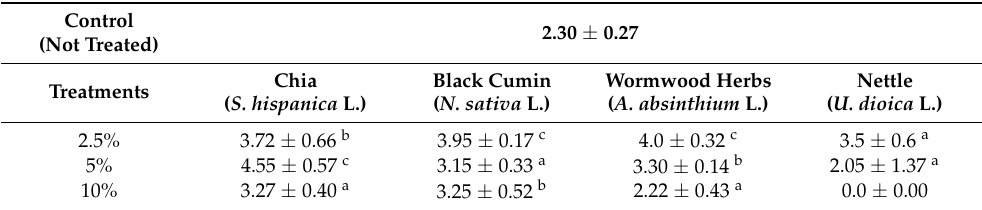
Table 10. Comparison of differences of means for hypocotyl length of lettuce ( L. sativa L.) seedlings (The values in the table represent the mean value of hypocotyl length in cm ±